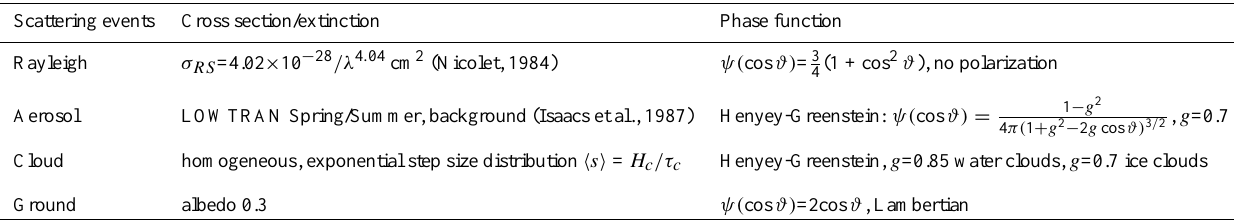
Table 1. Scattering characteristics used for the radiative transfer models Scattering events